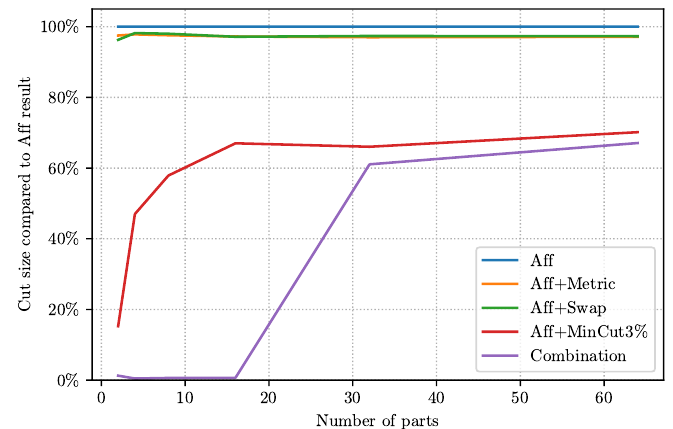
Figure 7. Cut value obtained by semilocal optimization methods on World-roads as compared to their baseline, AffCommNeigh